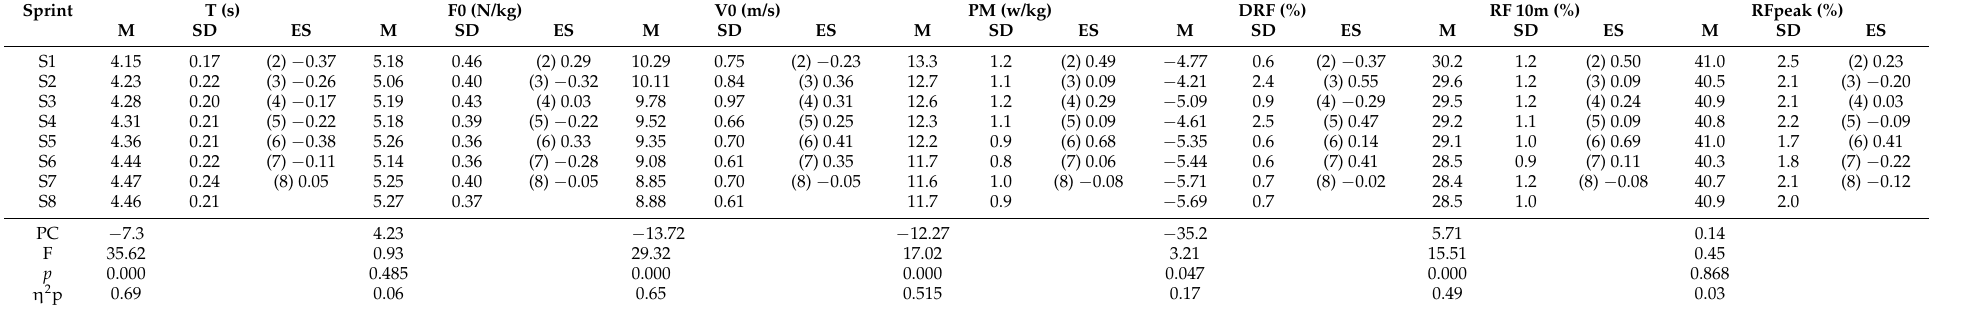
Table 1. Description and differences for the variables of the horizontal force-velocity